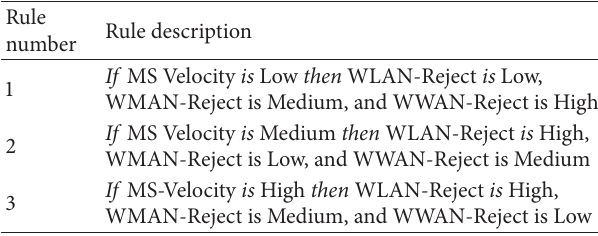
Table 5: Inference rule for